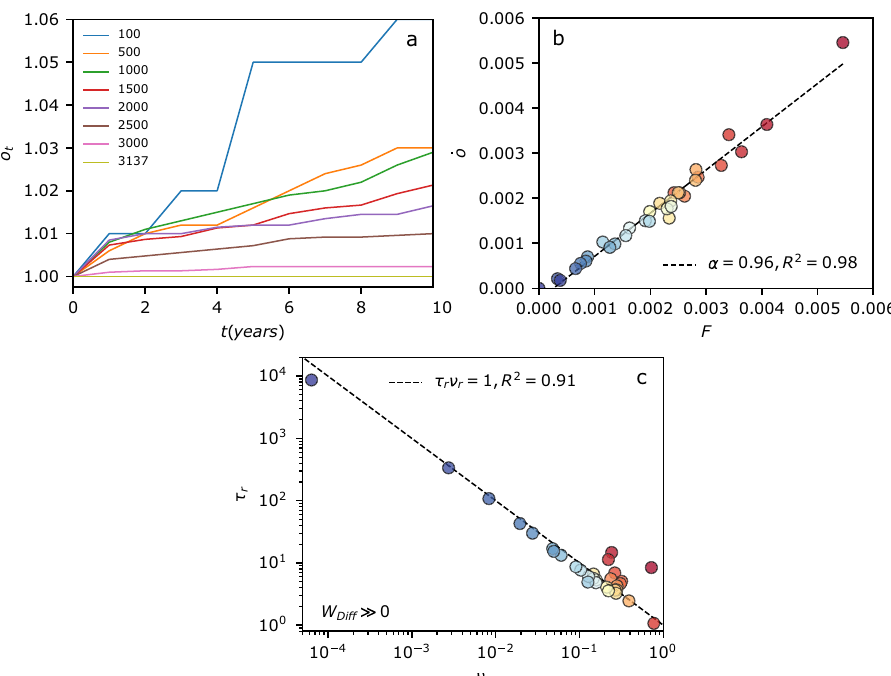
Fig. 5 Rank shifts are ruled by a diffusive process. a The turn over rate o t as function of t for N 0 = 100, 500, … , 3137. Open systems are more prone to the entrance of new elements, thus o t = 10 is higher for more open systems. b _ o can be approximated by the model _ o ¼ α F , indicating that there is a continuous transition from open to closed systems as the rank length increases from N 0 = 100 (blue dot) to N 0 = 3100 (red dot). c The reescaled parameters τ r and d r fall into the universal curve τ r d r = 1, as observed in open systems 37